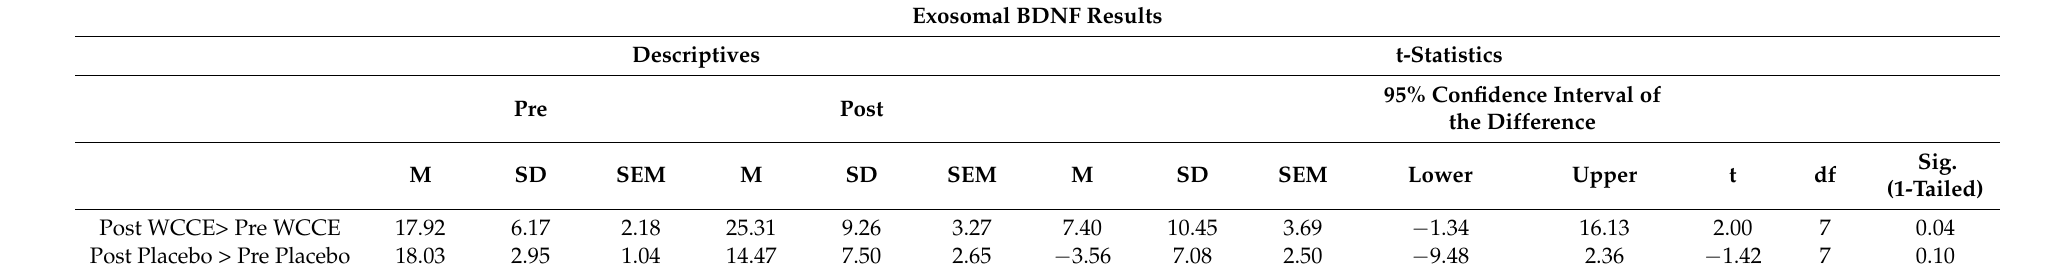
Table 2. Descriptive statistics of exosomal BDNF. Results indicated a significant increase in the exosomal BDNF level after the ingestion of WCCE when compared to pre-WCCE ingestion. No differences in exosomal BDNF were observed post-placebo ingestion when compared to pre-placebo baseline levels. M = mean, SD = standard deviation, SEM = standard error of the